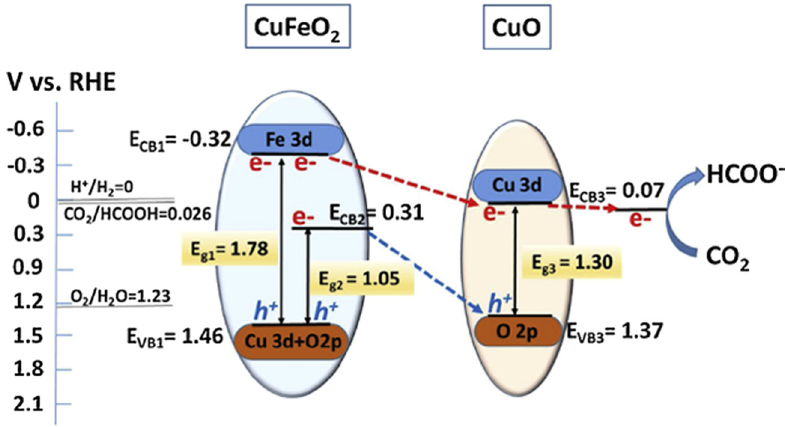
Figure 5: Electronic band diagram of CuFeO 2 /CuO heterojunction. ( Reprinted with permission from ref. [ 152 ] . Copyright © 2019, Elsevier )